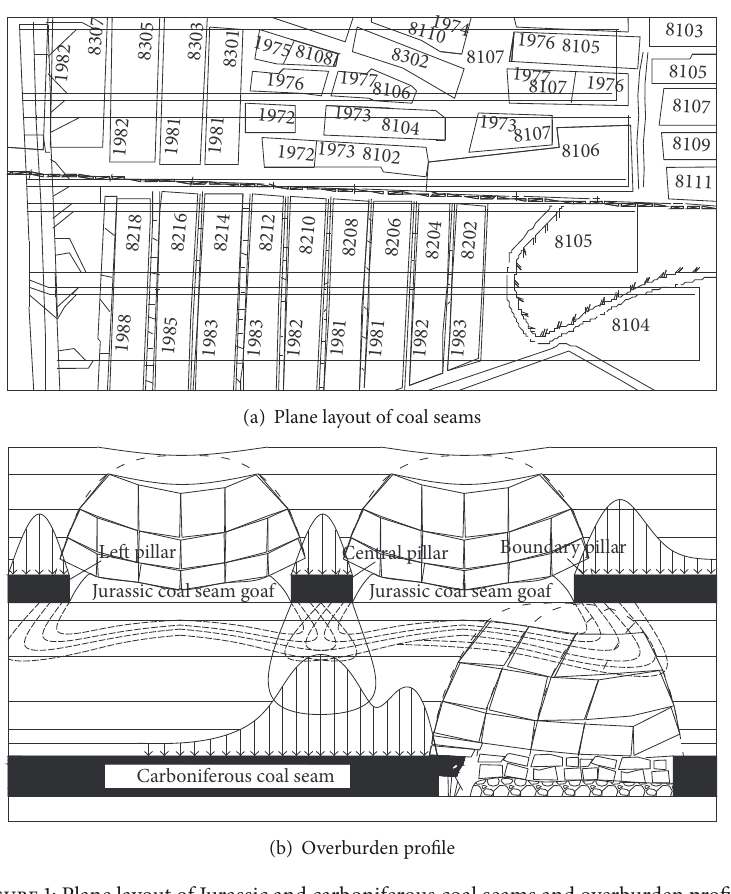
Figure 1: Plane layout of Jurassic and carboniferous coal seams and overburden profile.